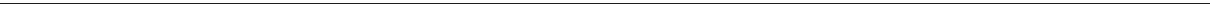
Fig. 5 Individual risk ratio (RR) maps in the circadian vs. multidien phase-space. a Scatterplots of circadian vs. multidien phase at time of seizures (total number of seizures on the right of ( c ), N ). Note that data have been duplicated on the x and y -axes to emphasize complete cycles. Each dot represents one to a few seizures happening during the same hour. P : peak, T: trough of underlying rhythms also represented with purple lines. The black (night, 6PM – 6AM) and white (day, 6AM – 6PM) boxes on the right y -axis represent approximate time of the day. Note the lack of correlation between the circadian and multidien angles (i.e., they do not align on a diagonal). Pink boxes in S33 highlight that, for a given multidien phase, IEA could go up or down in the hours before or after a seizure, depending on the circadian phase relative to peak (pink P ). b Corresponding density plots representing risk ratio (color-coded logarithmic scale) for bins of 20-degree circadian and multidien phase combination. Each pixel represents the risk of having a seizure at this point in phase-space as compared to the risk of not having a seizure at this point. Green and cyan lines in ( b ) with corresponding green and cyan shading in ( a ) ( ± 90°) represent preferred phases of seizures in relation to underlying IEA rhythms (also visible in Fig. 4). In some subjects, seizures can occur at any time of the day if in the at-risk multidien phase (S1, S5, S7, S13, and S24) and, conversely, in other subjects, seizures can occur on any day of the multidien cycle if at speci fi c times of the day (S4, S26, and S37). c Forest plot showing the risk ratio for having a seizure when in-phase vs. anti-phase with the